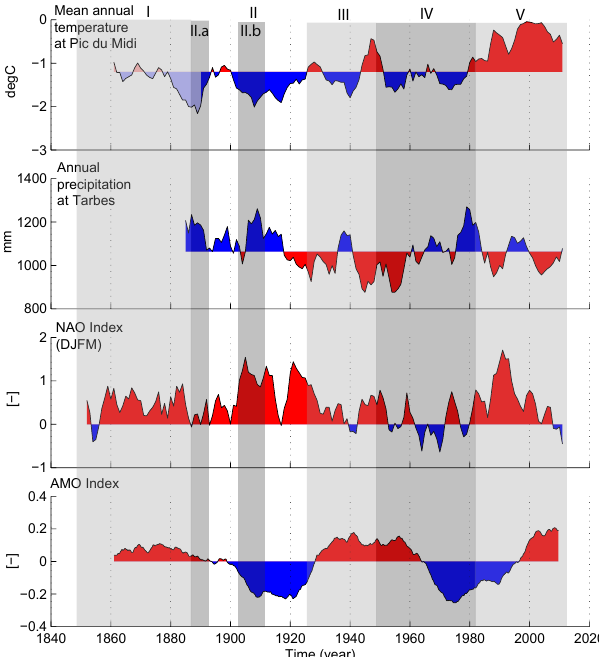
Figure 11. Climatic time series: mean annual temperature at Pic du Midi (beginning 1 October), annual precipitation at Tarbes, AMO mode and winter NAO (DJFM) anomalies. The background colour indicates the interpreted trend of the period, according to the metric variations (see Sect. 5.1 and Fig. 9). The ice depletion periods (I, III, V) are shown in light grey. The periods of accumulation or stability (II.a, II.b, IV) are shown in dark